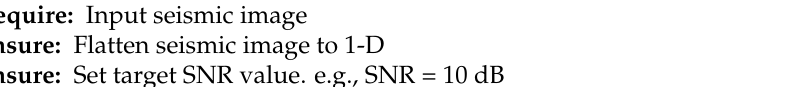
Algorithm 1 Algorithm to add noise to the seismic image.